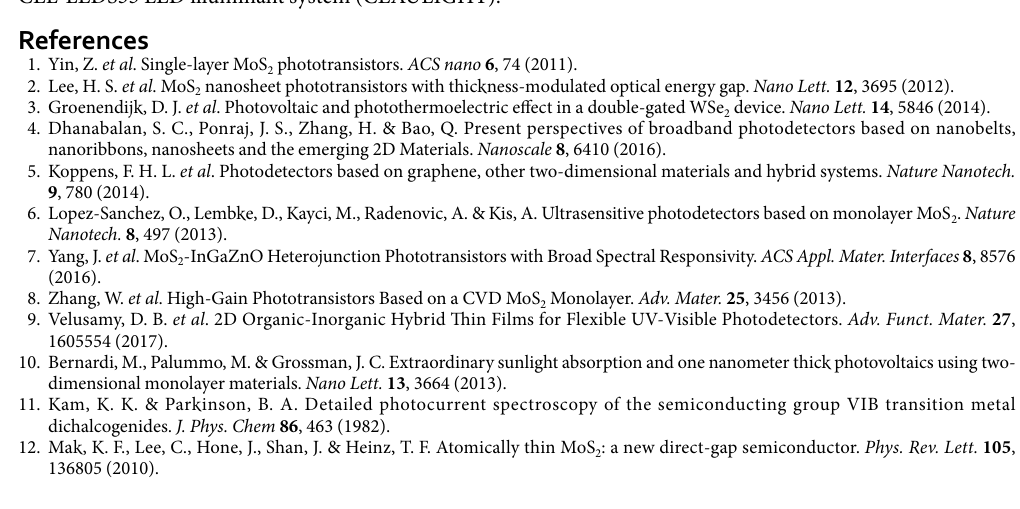
Method A multilayer/monolayer MoS 2 flake was obtained from a bulk crystal by mechanical exfoliation method and transferred to a highly p-doped Si (100) substrates with 90 nm thermal oxide as shown in the inset of Fig. 1(a). Metal source/drain (S/D) contacts are subsequently formed with source contact on the monolayer region and the other on the multilayer region of the MoS 2 flake. Then, electron-beam lithography (EBL) was used to pattern the source/drain contacts, followed by thermal evaporation of Ti/Au (10/50 nm) electrodes and lift-off process. The resulting structure is shown in Fig. 1(a) with channel length L of 3 μ m and width W of 7.4 μ m. Atomic force microscope (AFM, SPA 500, Seiko Instruments Inc.) and Raman spectroscopy (RM-1000, Renishaw) with a wavelength of 532 nm were used to confirm the layer number of MoS 2 flakes. The electronic and optical prop- erties of multilayer/monolayer MoS 2 heterojunction were characterized with an Agilent B1500 parameter ana- lyzer at room temperature in air ambient. The monochromic lights with different wavelengths were provided by CEL-LEDS35 LED illuminant system (CEAULIGHT).